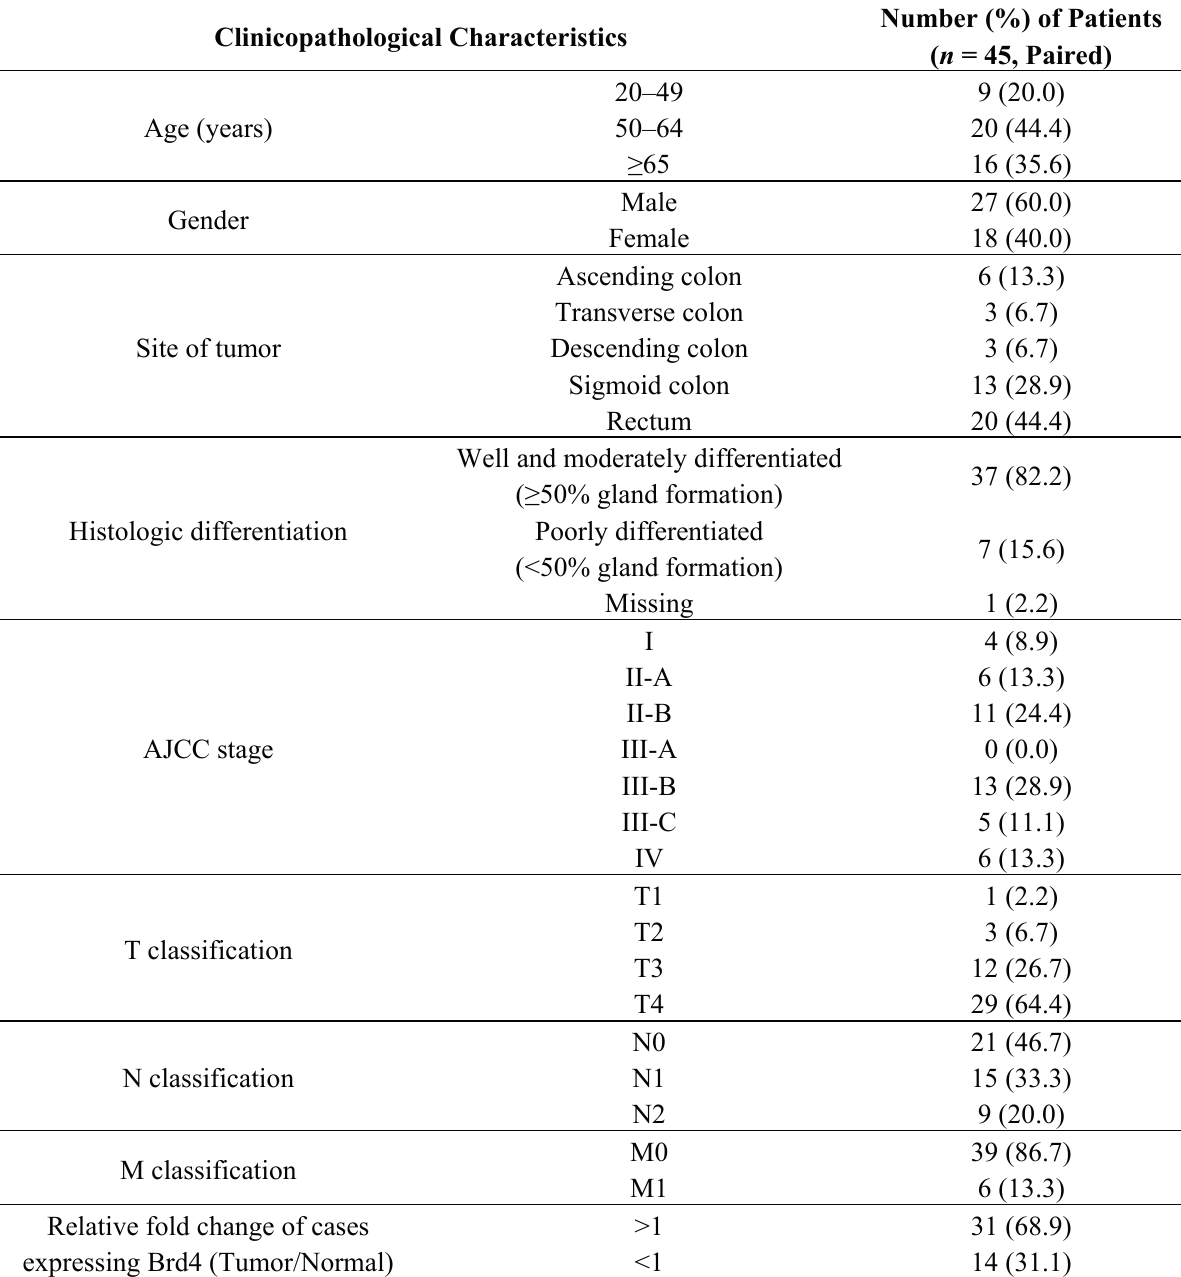
Table 1. Patients’ clinicopathological characteristics and Brd4 expression fold